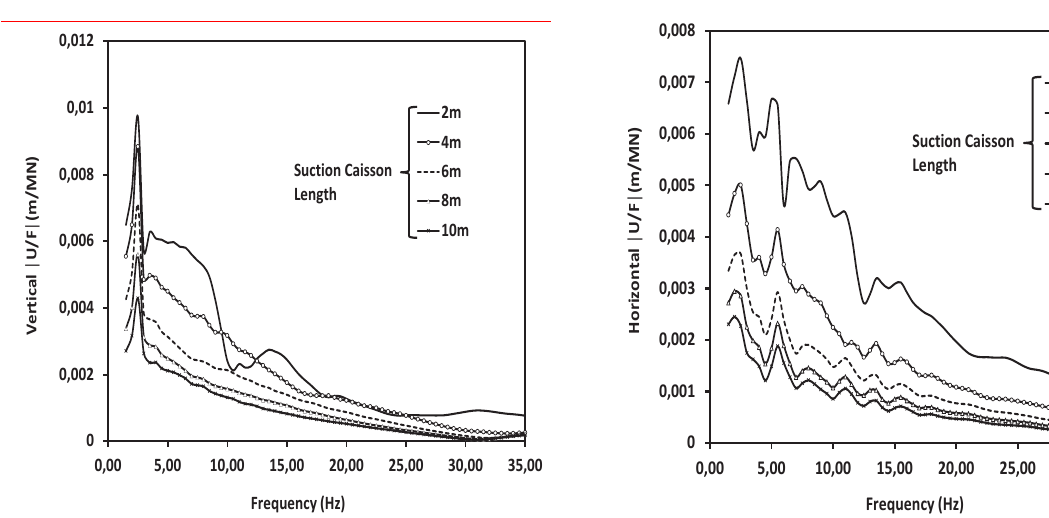
Figure 11: Variation of the horizontal dynamic impedance as a function of the cylinder length. Vertical and horizontal dynamic response of suction caisson foundations